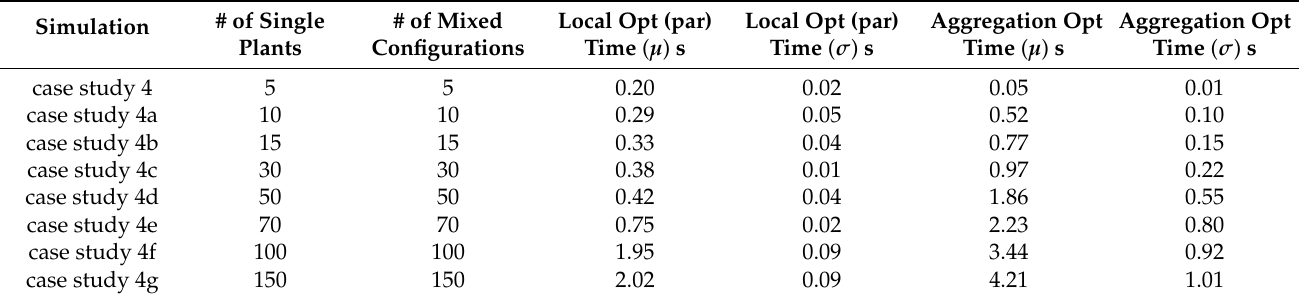
Table 6. Comparison number of plants/time for different size of simulation (case study 4) with local parallel optimization. Simulation